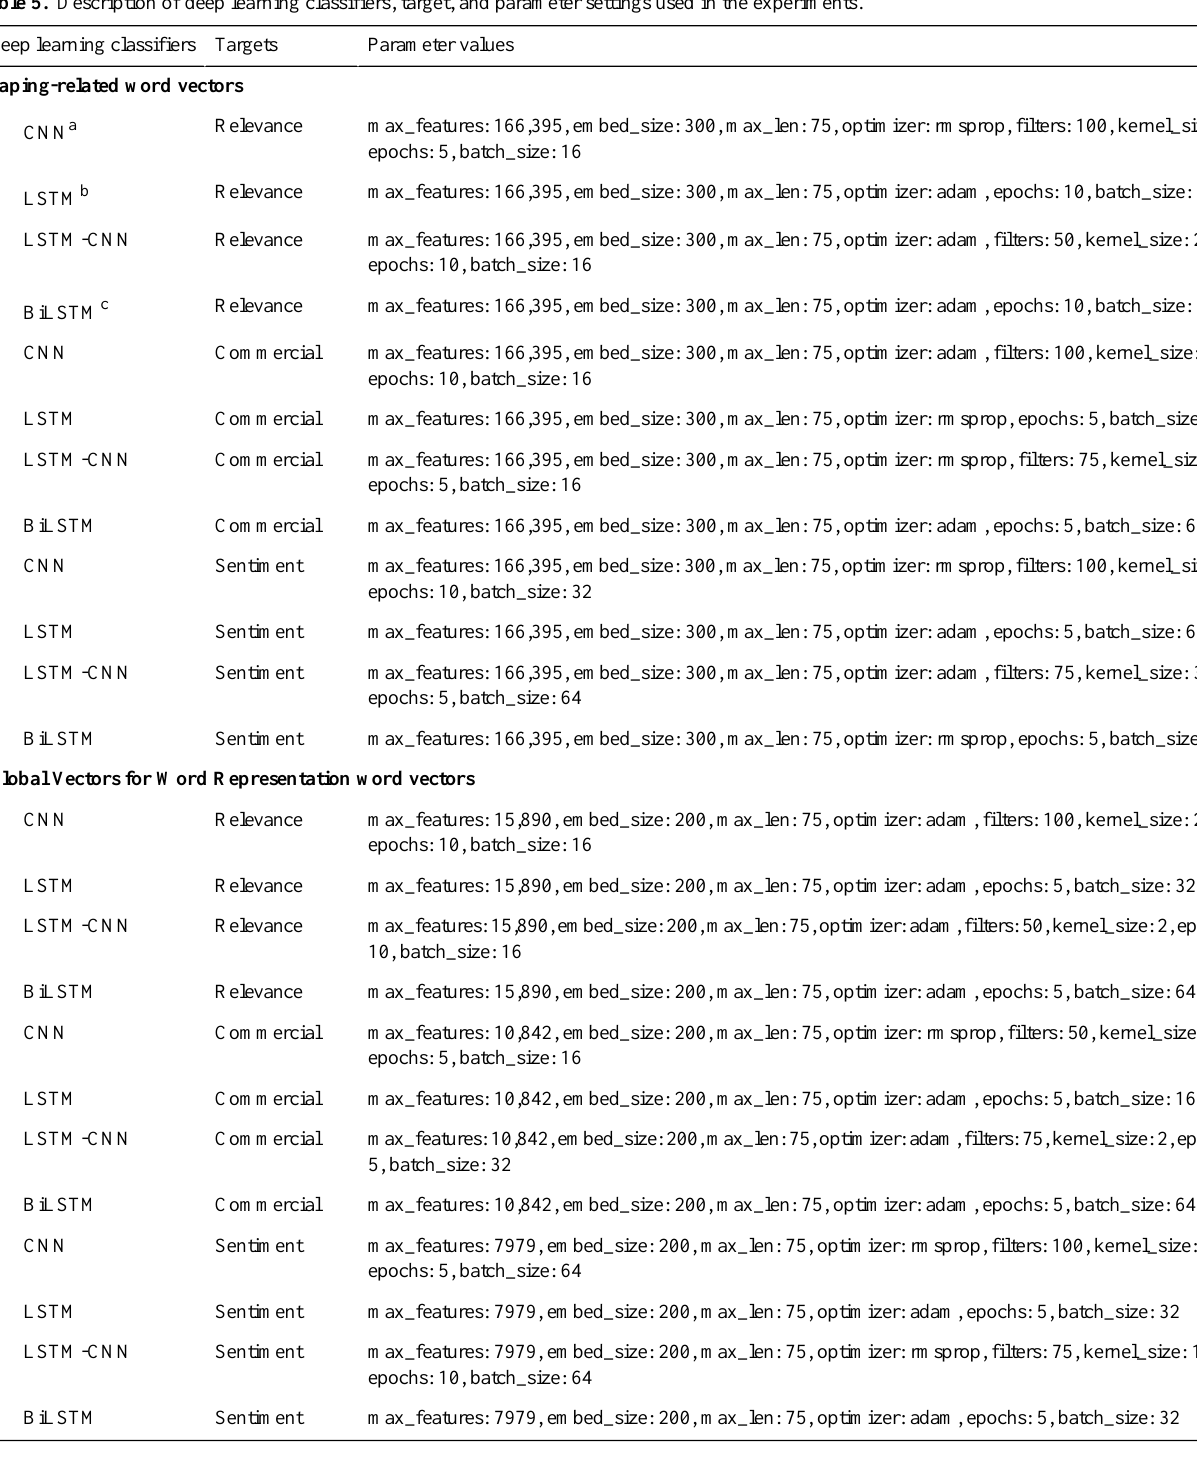
Table 5. Description of deep learning classifiers, target, and parameter settings used in the experiments.